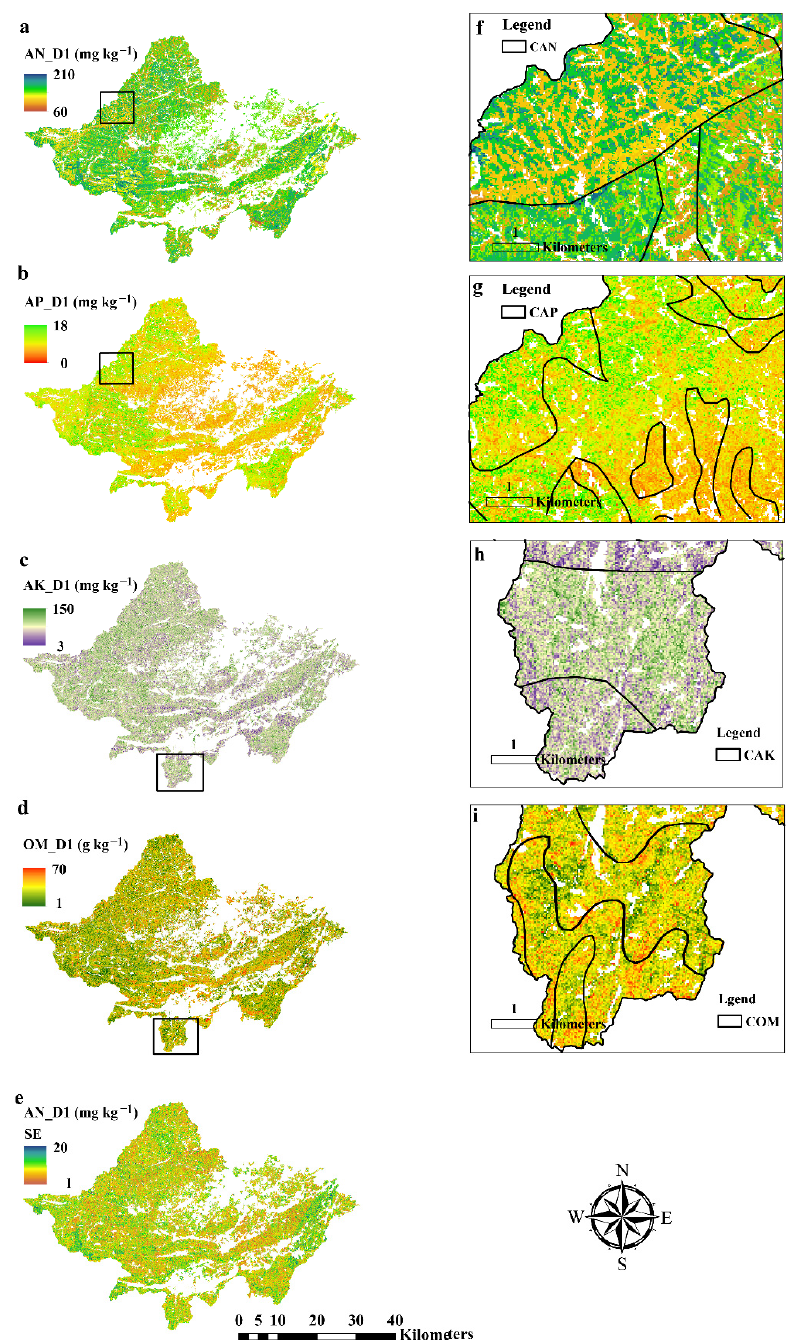
Figure 4. The spatial distribution of the D1 layer of AN ( a ), AP ( b ), AK ( c ), and OM ( d ). ( e ) is the standard error map of the D1 layer of AN. ( f – i ) represent a highlighted area in ( a – d ), respectively, showing detailed information and covering the boundary of the coarse-resolution maps. Table 6. Statistics of the predicted values for each soil layer.